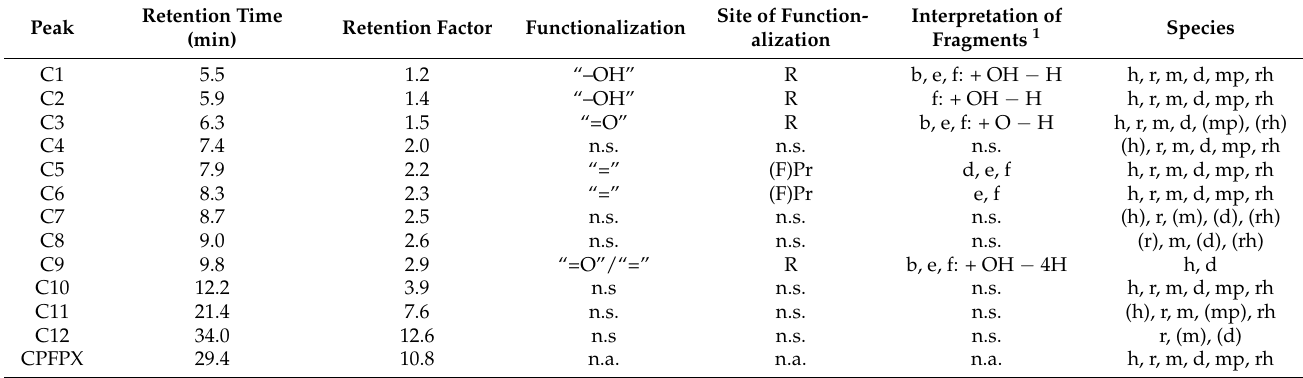
Table 4. Metabolites of CPFPX generated in liver microsomes from various